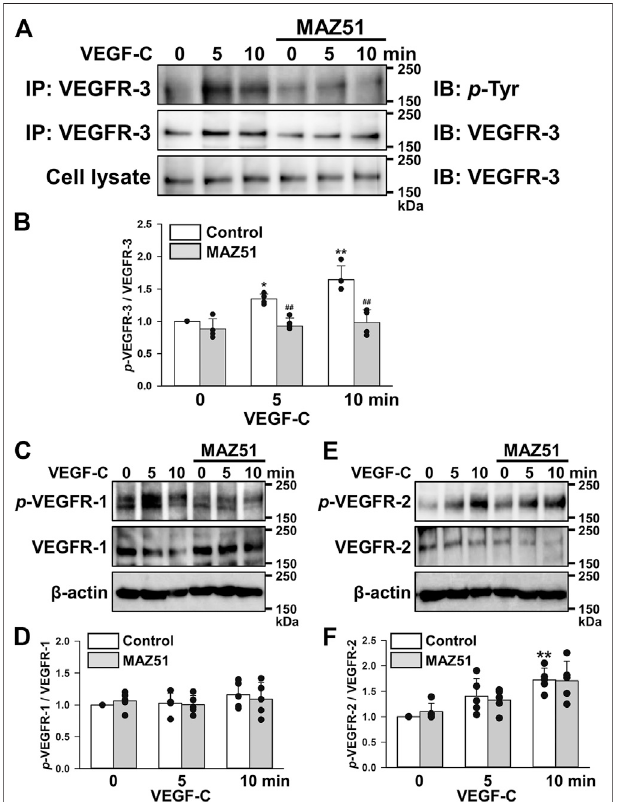
FIGURE 3 | Inhibition of the VEGF-C-induced phosphorylation of VEGFR-3 by MAZ51. The phosphorylation of VEGFRs after a stimulation with VEGF-C (aligand forVEGFR-2 and VEGFR-3)inthe absenceand presenceof MAZ51 in human prostate cancer PC-3 cells using Western blotting and co-immunoprecipitation methods. (A) Representative blots of phosphorylation of VEGFR-3 stimulated by 50 ng/ml VEGF-C in the absence and presence of 3 μ M MAZ51 for 4 h in PC-3 cells. (B) The phosphorylation level of VEGFR-3 by the VEGF-C stimulation in the absence and presence of MAZ51 in PC-3 cells ( n (cid:1) 4). (C) Representative blots of phosphorylation of VEGFR-1 stimulated by VEGF-C in the absence and presence of MAZ51 in PC-3 cells. (D) The phosphorylation level of VEGFR-1 by the VEGF-C stimulation in the absence and presence of MAZ51 in PC-3 cells ( n (cid:1) 5). (E) Representative blotsofphosphorylationofVEGFR-2 stimulated byVEGF-C in the absence and presence of MAZ51 in PC-3 cells. (F) The phosphorylation level of VEGFR-2 by the VEGF-C stimulation in the absence and presence of MAZ51 in PC-3 cells ( n (cid:1) 5). Data are presented as means ± S.D. * p < 0.05, ** p < 0.01 vs. 0 min; ## p < 0.01 vs. control (unpaired two-tailed t -test).